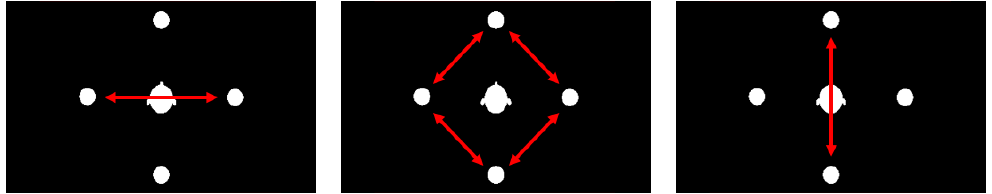
Figure 5. Target–distractor position combinations. Left : left–right; center : next-to; right :